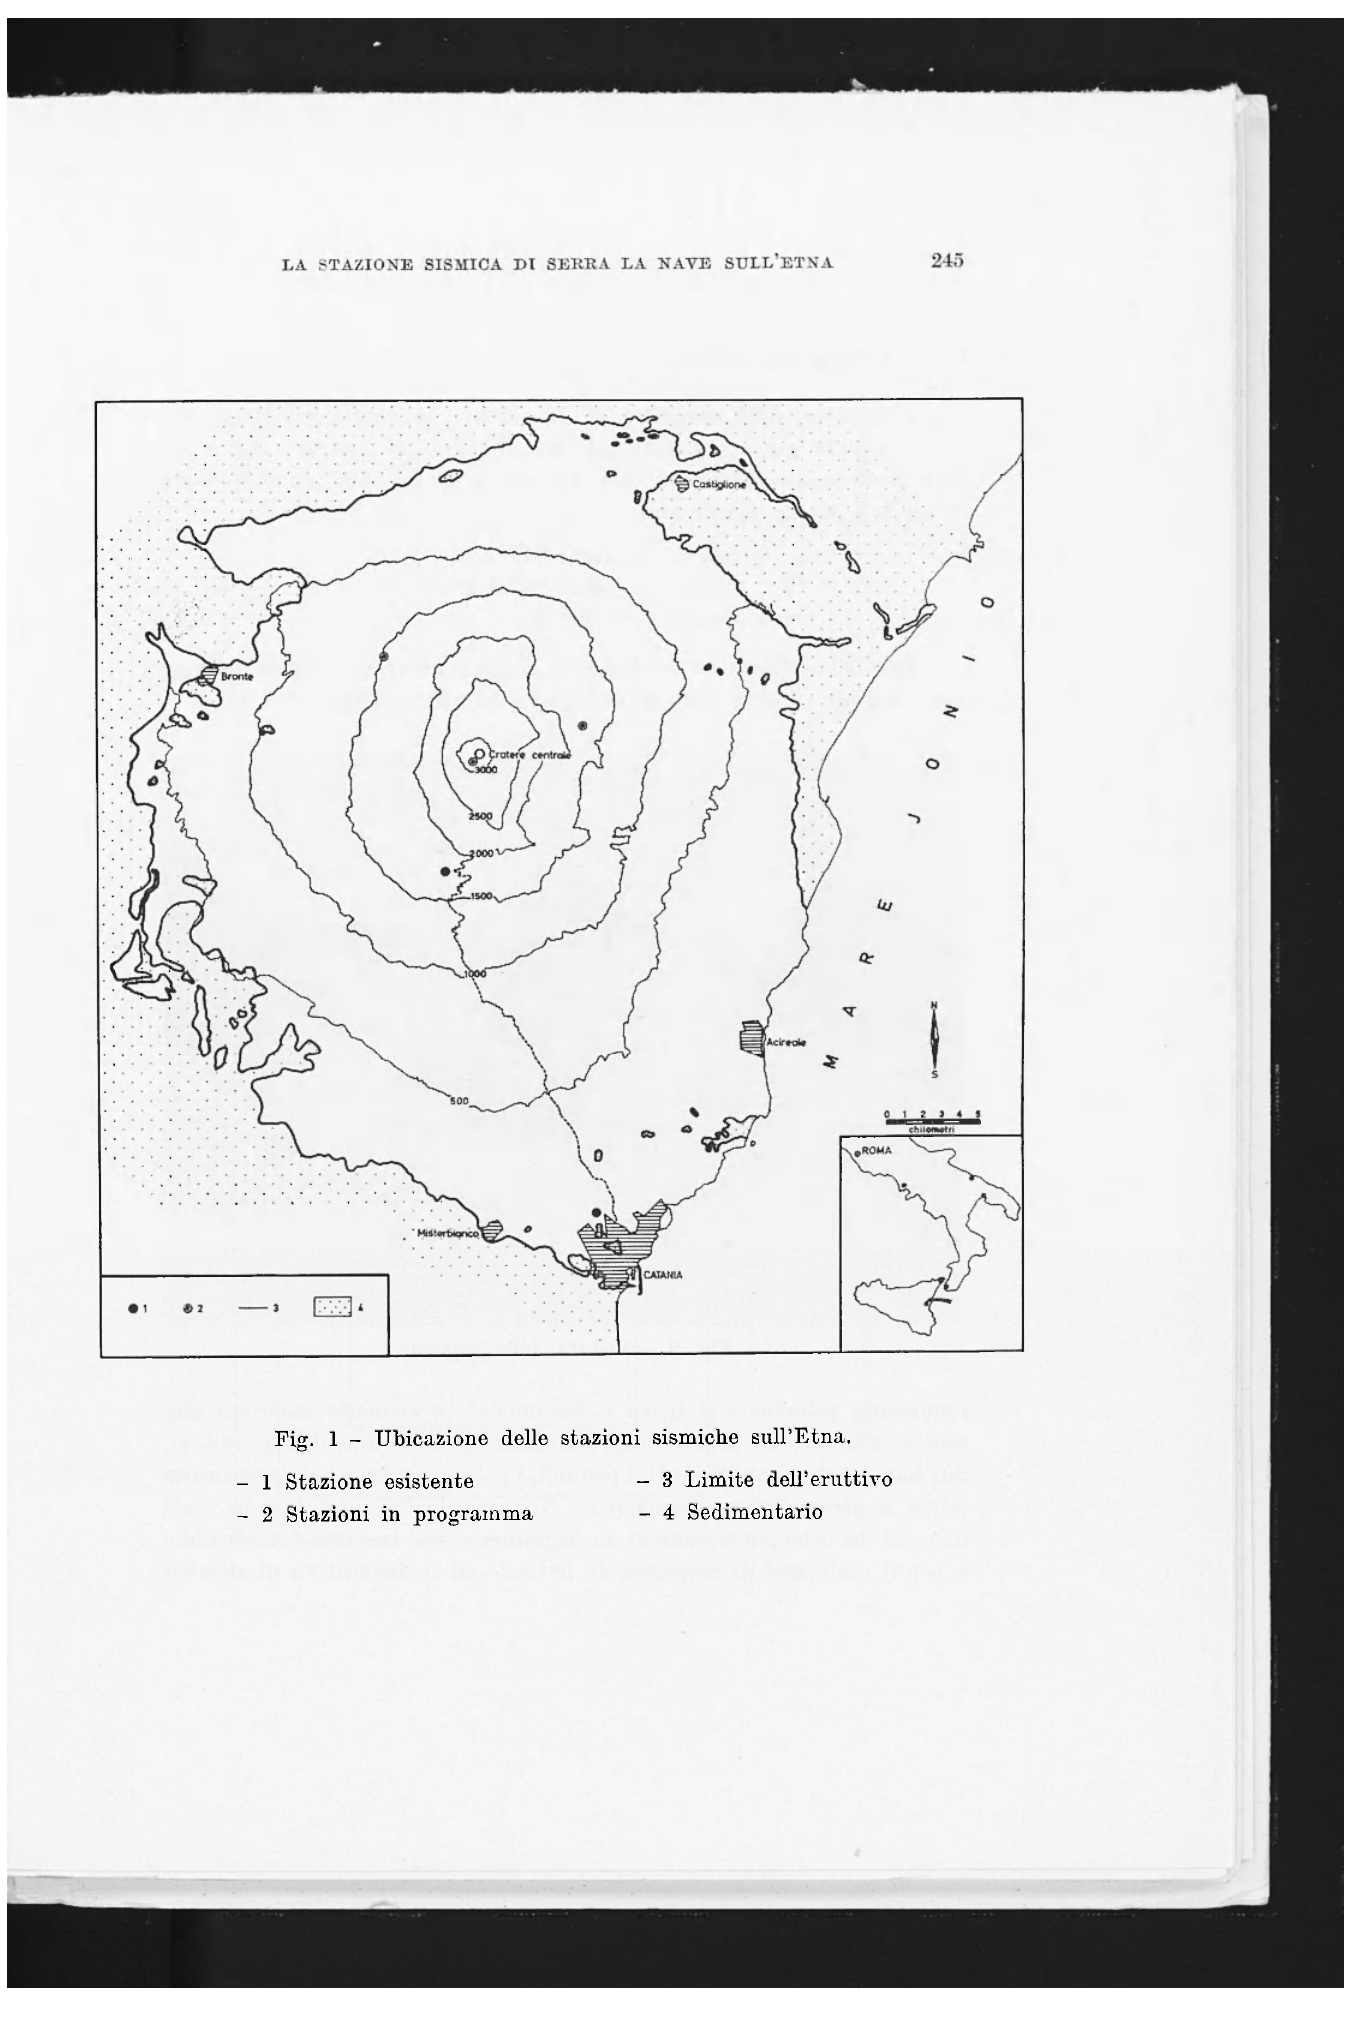
Fig. 1 - Ubicazione delle stazioni sismiche